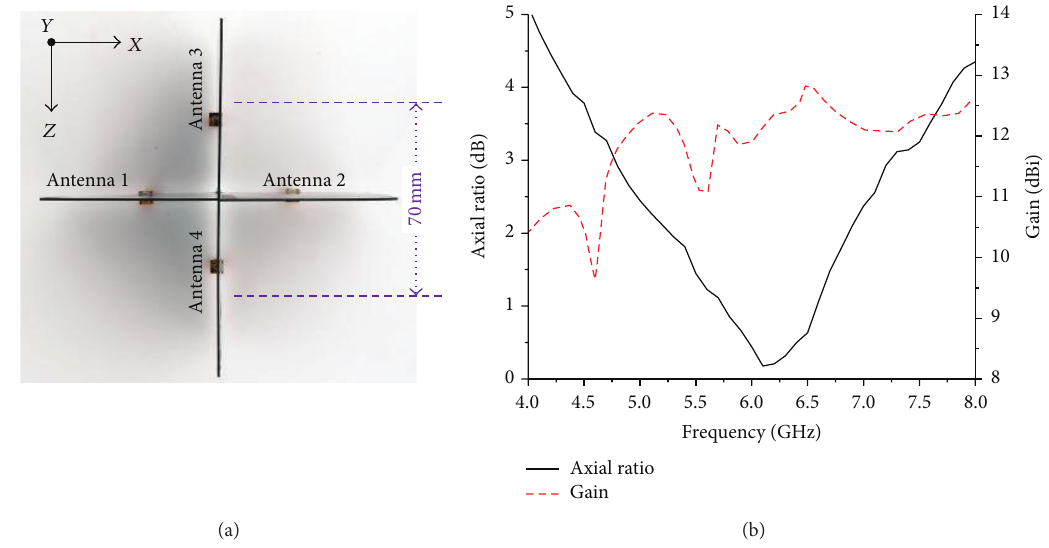
Figure 4: (a) Top view of the antenna array. (b) Simulated axial ratio and gain of the